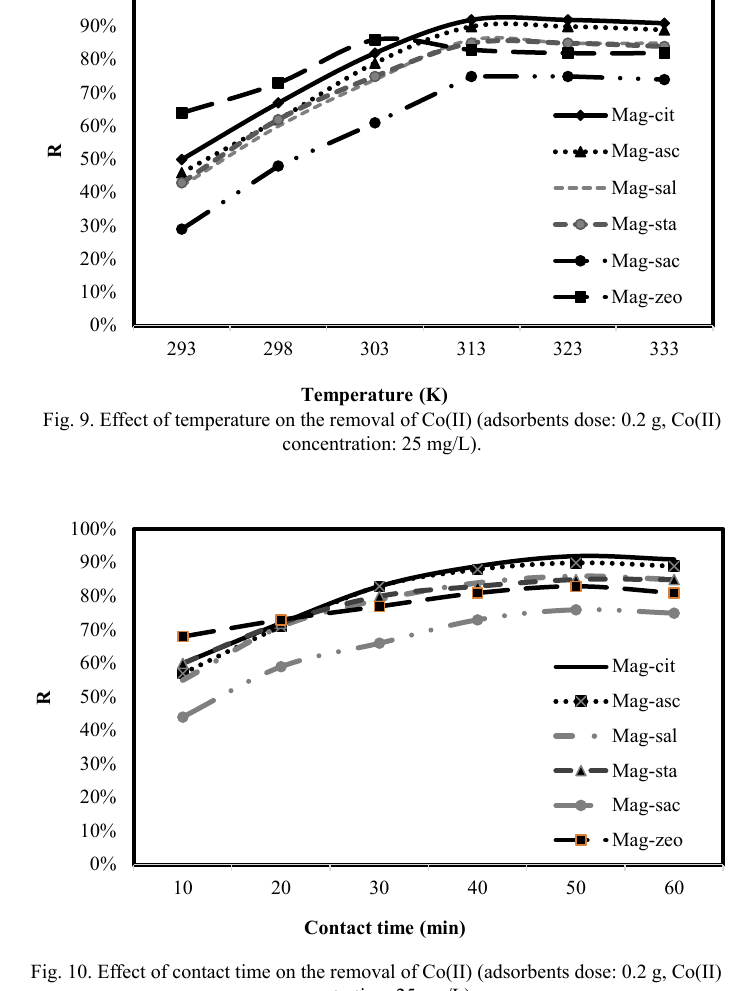
J. Water Environ. Nanotechnol., 2(3): 174-185, Summer 2017